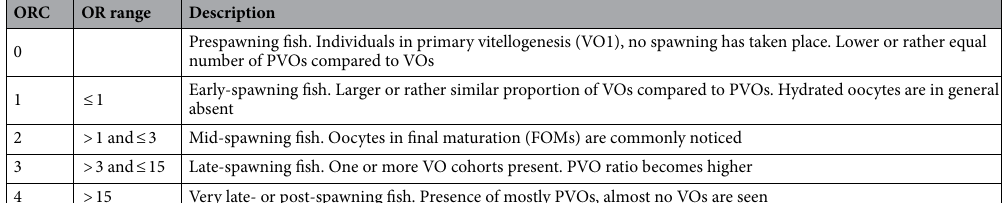
Table 1. Description of oocyte ratio category (ORC) and the oocyte range (OR) for Northeast Atlantic mackerel ( Scomber scombrus ) based on the description presented in Anderson et al. 10 , using wholemount analyses. Note that especially previtellogenic oocytes (PVOs) might be underestimated compared to OPD- based results. For further information on number of oocytes recorded automatically by the image analyser, see Supplementary Fig.